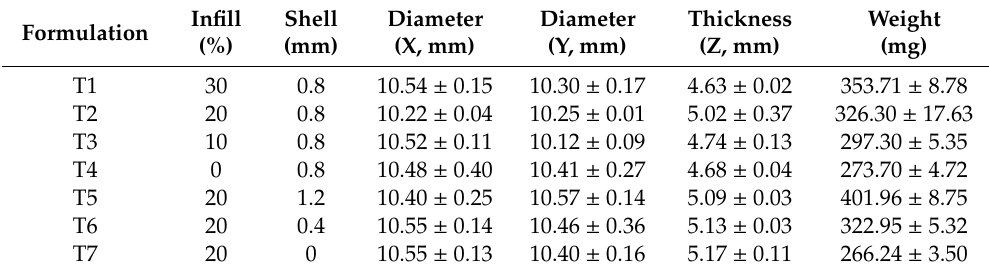
Table 1. Physical properties of the 3D printed floating tablets with varied infill densities and outside shell